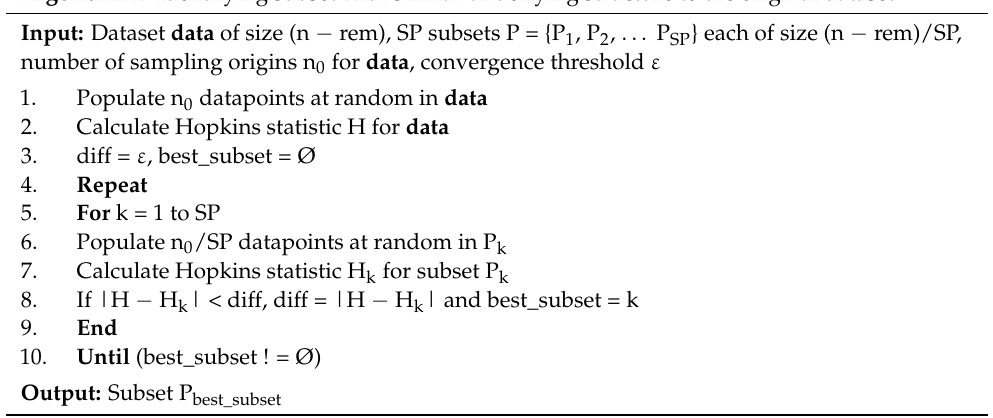
Algorithm 2 : Identifying subset with similar underlying structure to the original